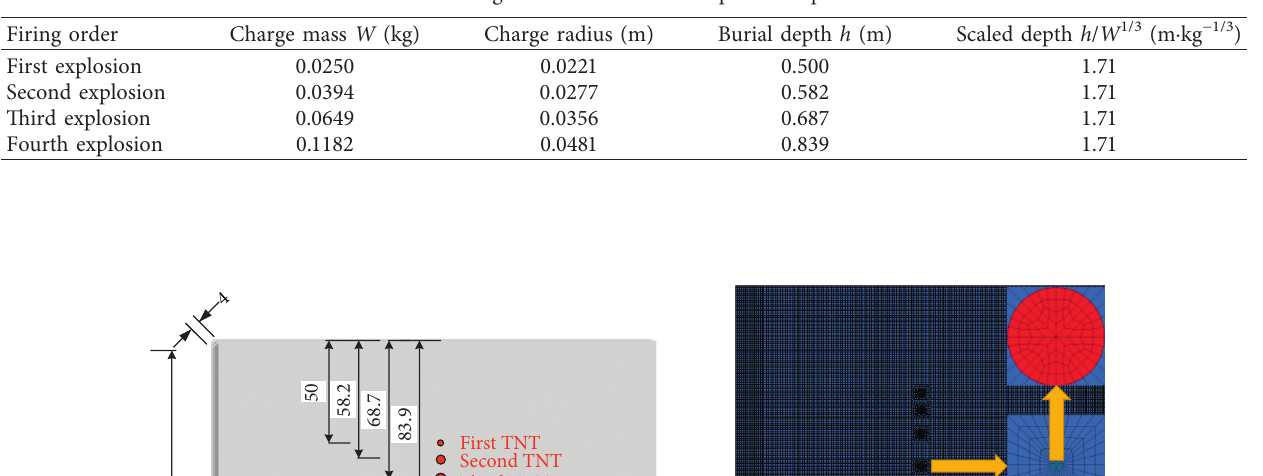
Figure 1: Geometry of the test model (unit: cm). (a) Full scale. (b) 1/2 symmetric geometrical model. Table 1: Charge masses and buried depths of explosives.